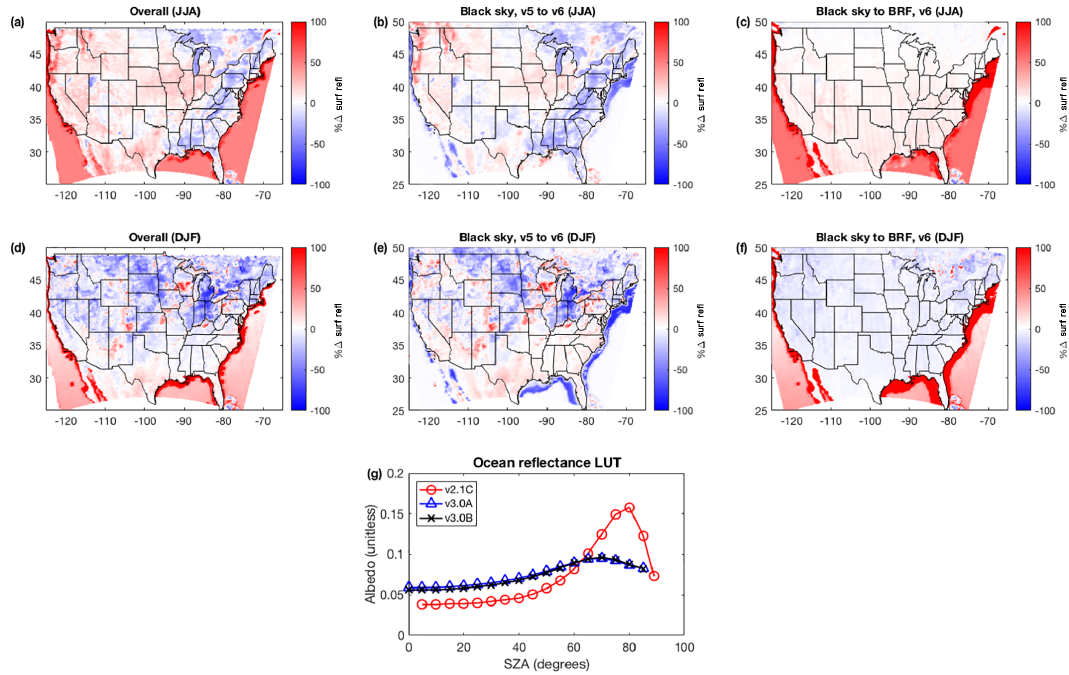
Figure 3. (a, d) Difference in surface reflectance between BEHR v2.1C (MODIS MCD43C3 black sky albedo, old ocean look-up table) and BEHR v3.0B (MODIS MCD43Dxx BRF, new look-up table). (b, e) Difference in surface reflectance between versions 5 and 6 of the MODIS black sky albedo (no change in ocean look-up table). (c, f) Difference in surface reflectance between the MODIS black sky and BRF product and the change in the ocean look-up table. (a–c) are for summer (JJA) and (d–f) are for winter (DJF). (g) The ocean albedo look-up table values for v2.1C, v3.0A, and v3.0B. (The change between v3.0A and v3.0B is discussed in Sect. 5.2.)